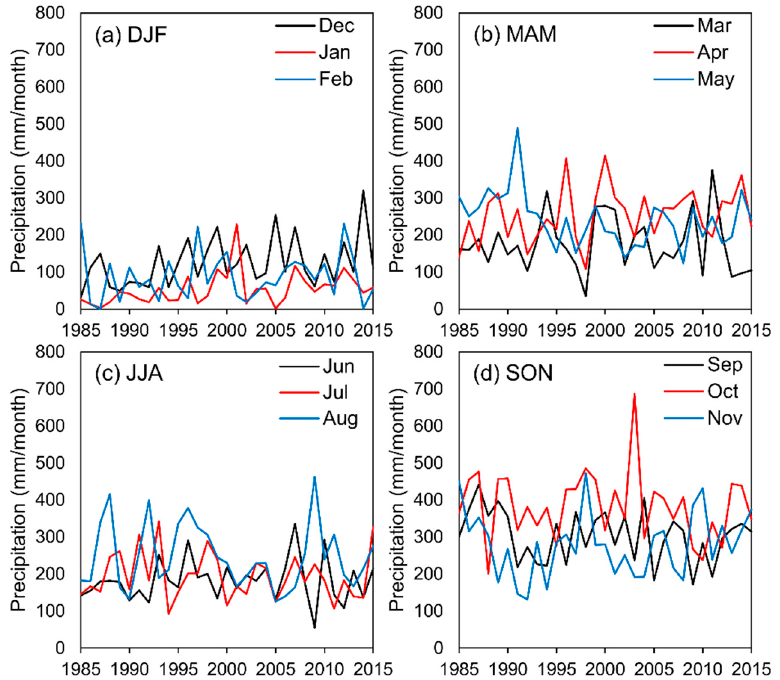
Figure 2. Temporal trends of monthly precipitation of the Muda River Basin in ( a ) December– January–February (DJF), ( b ) March–April–May (MAM), ( c ) June–July–August (JJA), and ( d ) September–October– November (SON) seasons from 1985 to